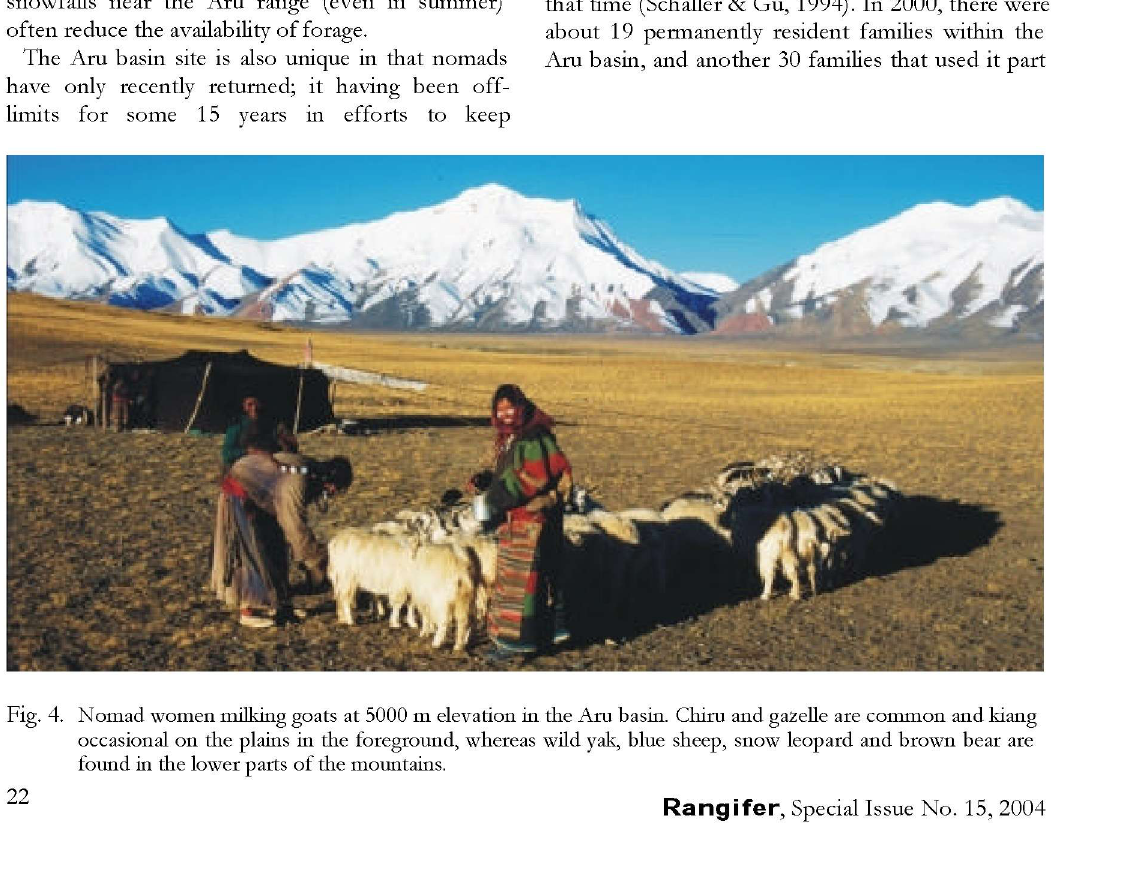
Fig. 4. Nomad women milking goats at 5000 m elevation in the Aru basin. Chiru and gazelle are common and kiang occasional on the plains in the foreground, whereas wild yak, blue sheep, snow leopard and brown bear are found in the lower parts of the